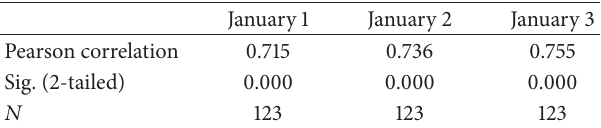
Table 2: The correlation between correlation degree and trip gener- ation.